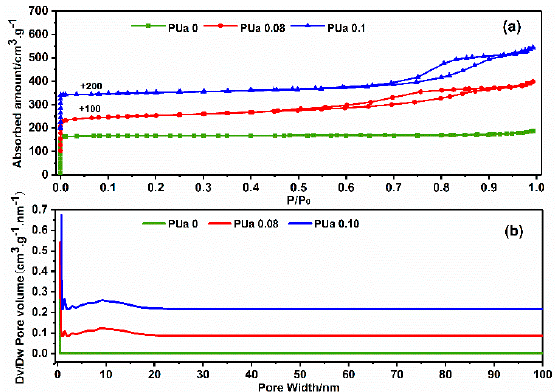
Figure 7 . ( a ) N 2 adsorption/desorption isotherms and ( b ) DFT pore size distribution curves of the as- synthesized SAPO-34 samples with and without PUa as